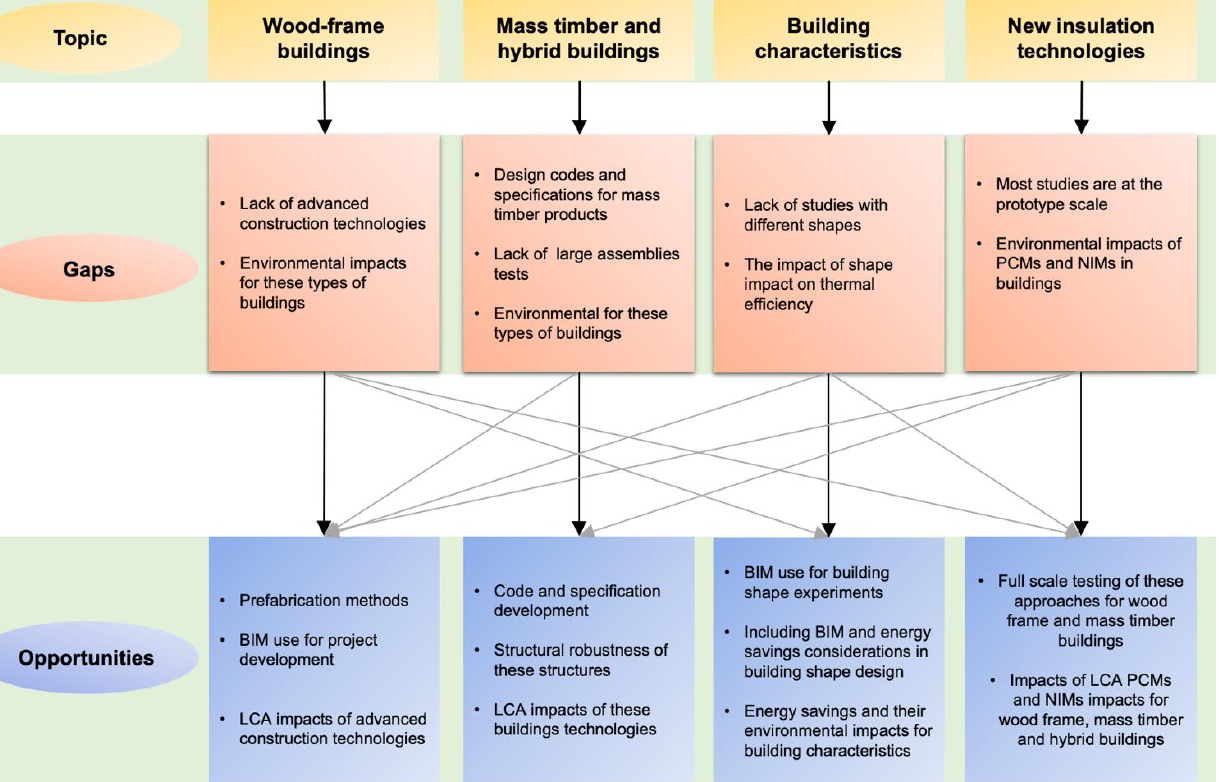
Figure 8. Research opportunities for wood constructions.